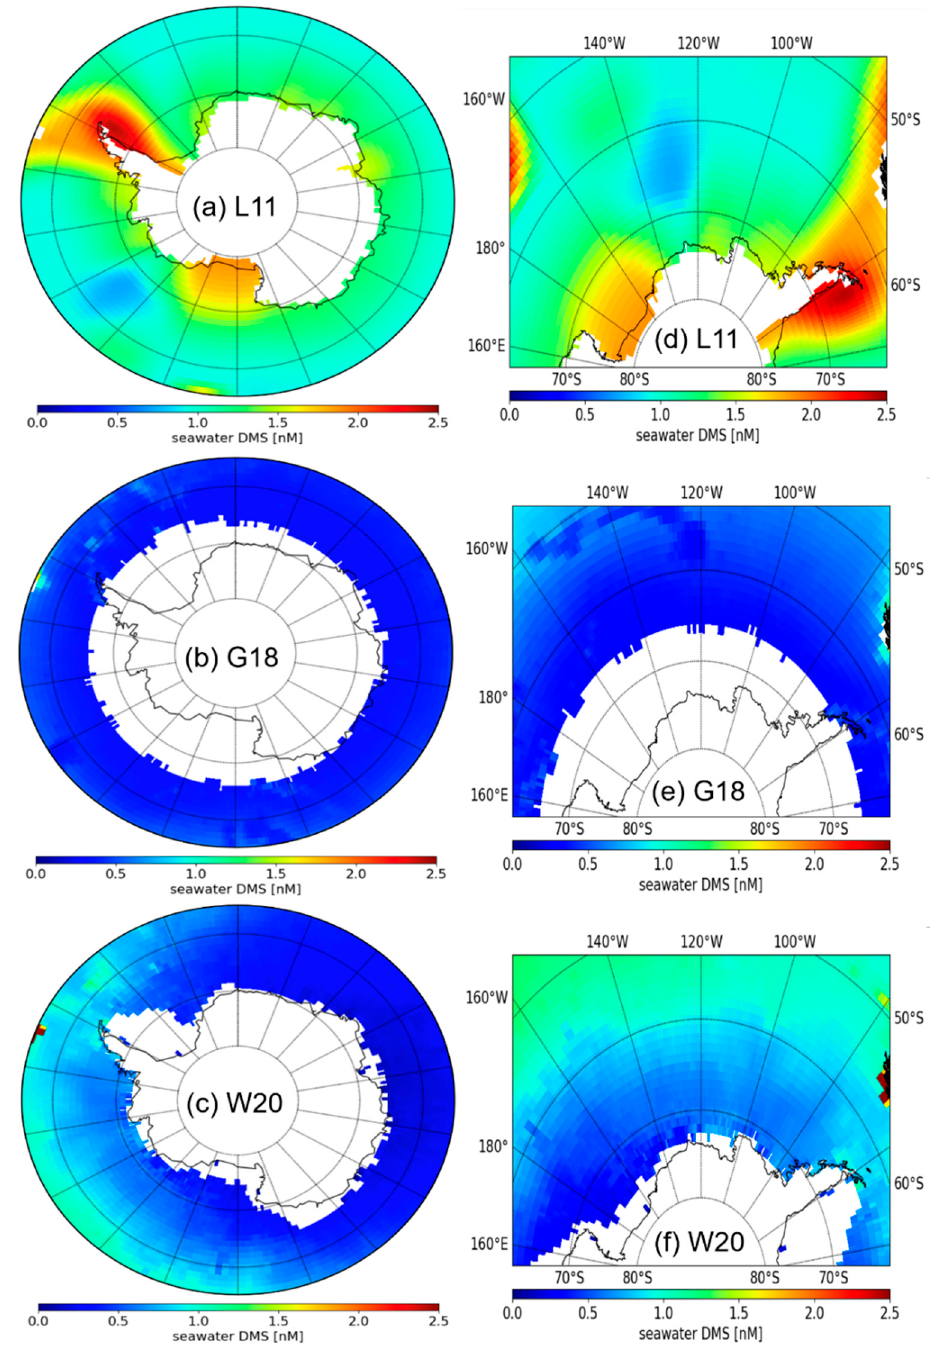
Figure 3. Maps of DMS levels estimated from three different inventories: ( a – c ) map of the entire Southern Ocean; ( d – f ) map of the Antarctic Peninsula coastal region. L11, G18, and W20 represent the data from Lana et al. [21], Gali et al. [22], and Wang et al. [23], respectively.